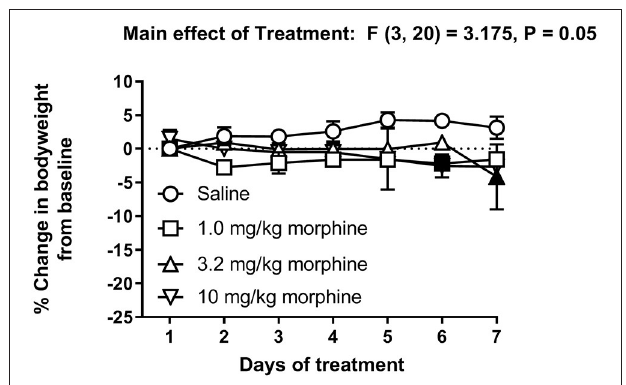
FIGURE 4 | nesting on all test days. Filled points represent statistical significance ( P < 0.05) vs. saline as indicated by a significant treatment x time interaction in the two-way repeated measures ANOVA with Bonferroni’s test. Sample sizes for the experimental groups are as follows: Saline (6/day), 1.0 mg/kg morphine (6/day), 3.2 mg/kg morphine (7/day) and 10 mg/kg morphine (5/day).